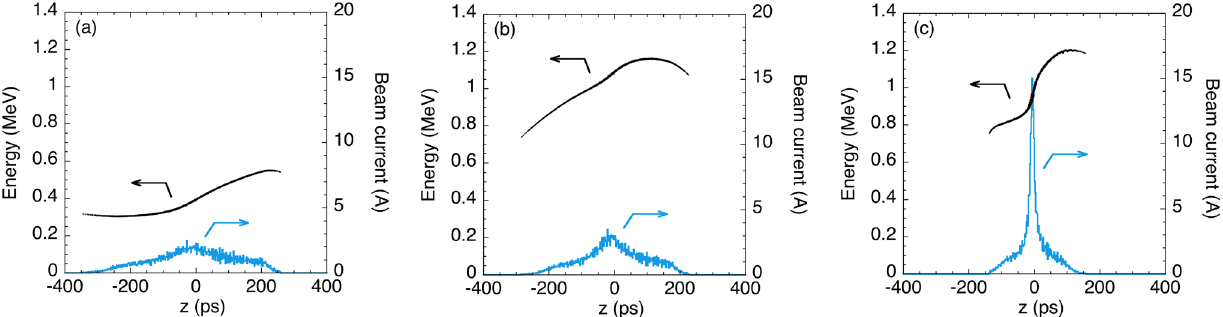
FIG. 3. Energy profile (black dots) and beam current (blue line) as functions of the bunch longitudinal position (time), simulated using PARMELA. (a), (b), and (c) correspond to three locations: after the 238-MHz SHB, after the 476-MHz booster cavity, and before the L-band accelerator, respectively. Part of the energy profile is linearized by the L-band correction rf cavity. The left side of each plot corresponds to the bunch head.